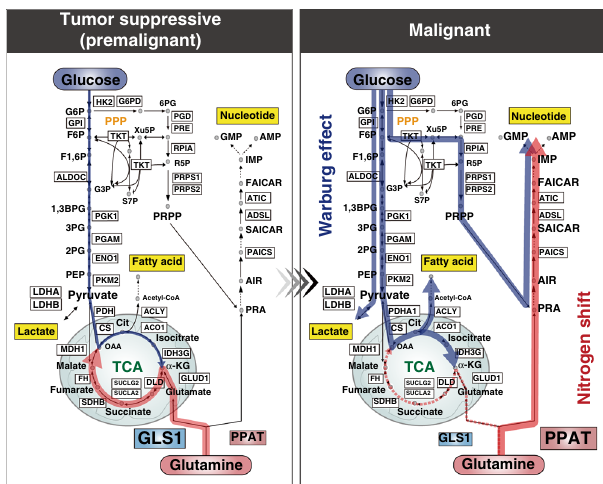
Fig. 8 The fate of nitrogen in glutamine is shifted in a model of malignant progression. Proteomic and metabolomic analyses unveil the entire landscape of metabolic changes in a model of malignant cancer. In addition to the carbon shift of the Warburg effect, a nitrogen shift plays a key role in malignant progression in the model. PPAT and GLS1 are decisive factors controlling the nitrogen shift from